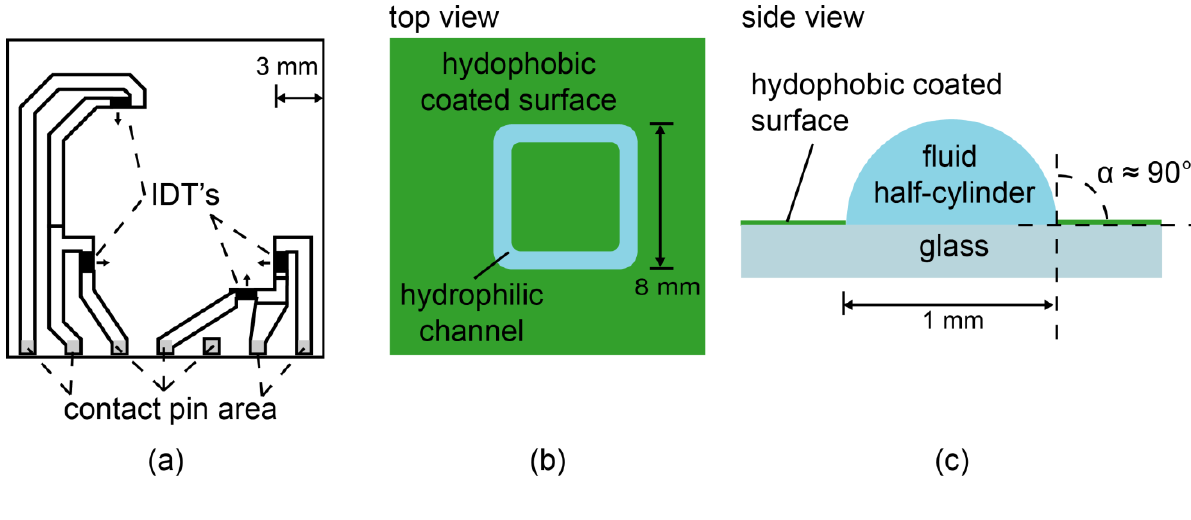
Figure 1. ( a ) Sketch of the inter-digital transducer (IDT) layout deposited on bare LiNbO 128° Rot Y -Cut. The small arrows indicate the direction of the surface acoustic wave (SAW) propagation. The surface is covered with SiO view ( b ) and the side view ( c ) of a hydrophilic channel (blue) surrounded by the surface coated with hydrophobic